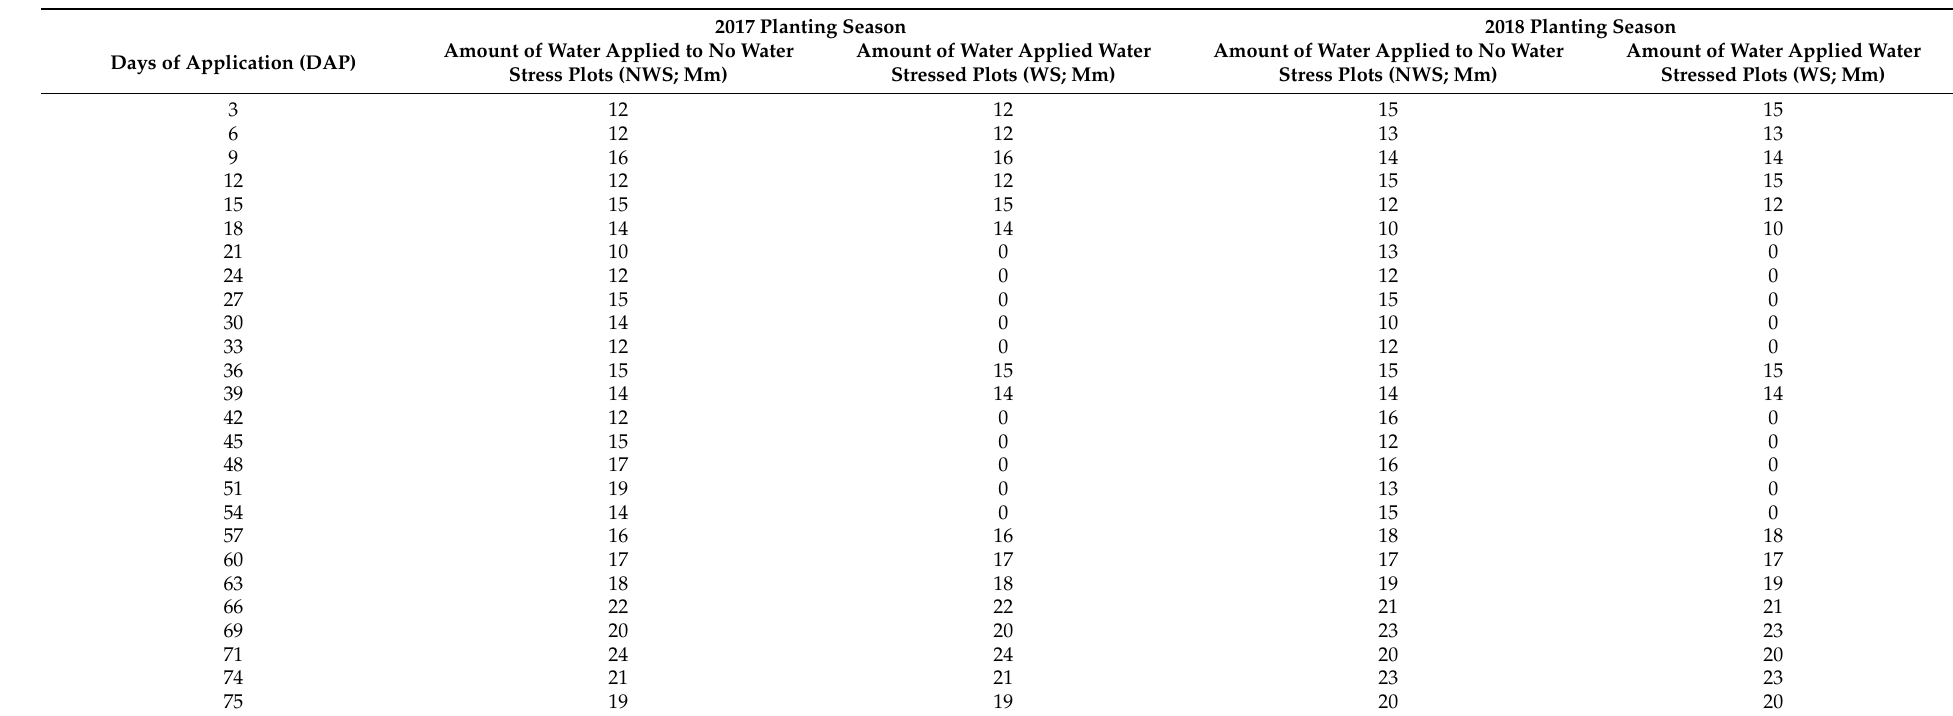
Table 3. Irrigation schedule showing amount of water applied (mm) and days of application in the water stress (WS) and no water stress (NWS) treatments in 2017 and 2018 planting